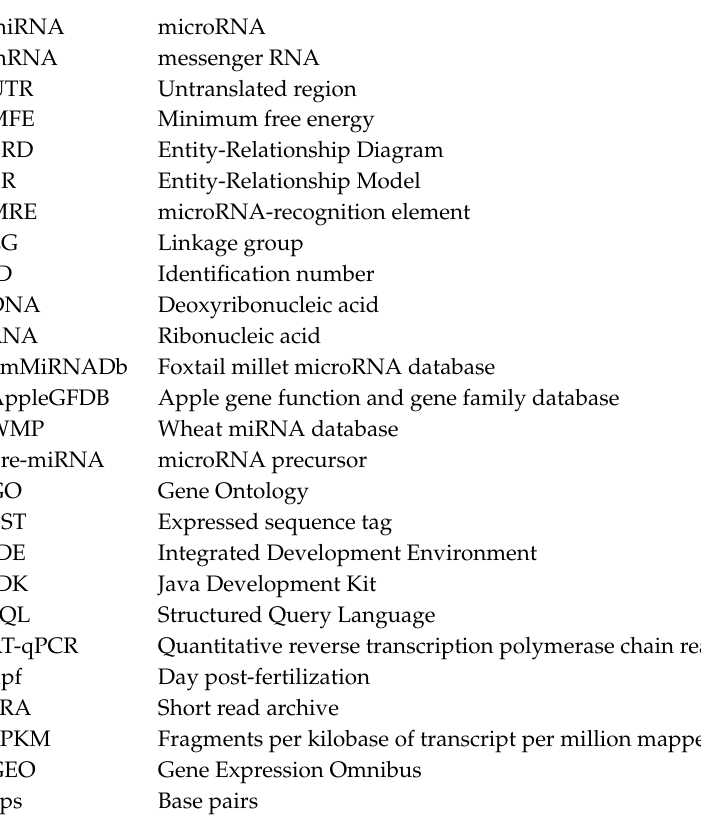
Figure S1: Distribution of TargetScan context+ scores of predicted miRNA interactions, Figure S2: Degree distribution of nodes from predicted Nile tilapia miRNA-mRNA interactions network, Figure S3: Example of the genomic location search mechanism in advanced search page, Figure S4: Simple miRNA information resulted from the genome location search mechanism, Figure S5: Example of sample search mechanism on the advanced search page, Figure S6: miRNA information obtained by sample search mechanism, Figure S7: Case study of miRNA with multiples samples or predicted targets